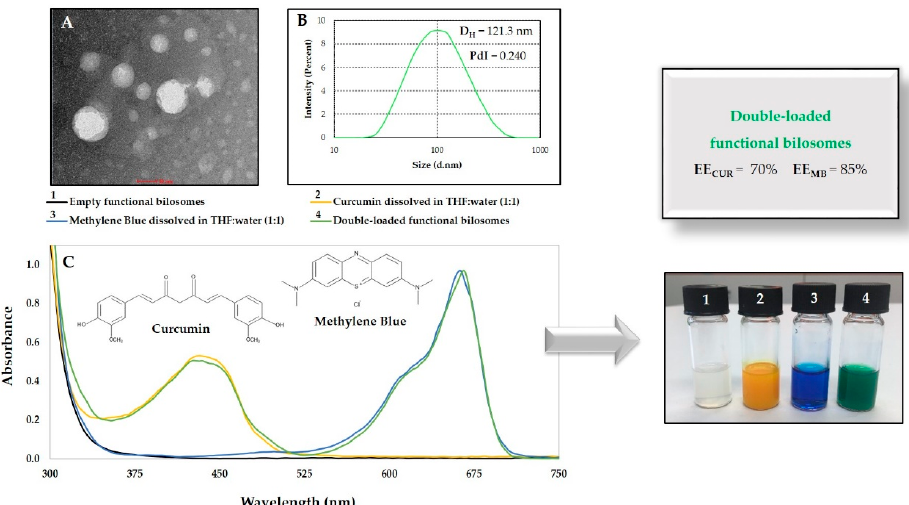
Figure 6. Characteristics of the functional bilosomes after the hybrid cargo encapsulation using ( A ) TEM, ( B ) dynamic light scattering (DLS), ( C ) UV-Vis spectra. UV-Vis absorption spectra and images of the ( 1 ) empty functional bilosomes, ( 2 ) curcumin and ( 3 ) methylene blue dissolved in THF:water (1:1) and ( 4 ) double-loaded functional bilosomes. The colors of the lines ( C ) correspond with the colors of the samples.